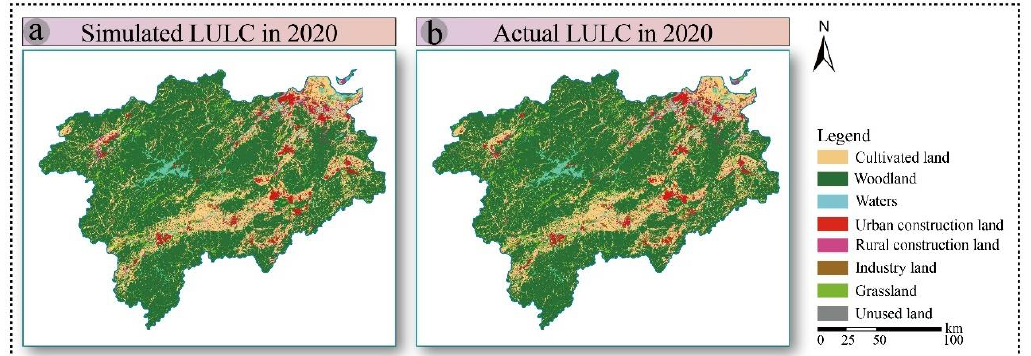
Figure 7. Comparison of simulated ( a ) and actual LULC ( b ) in